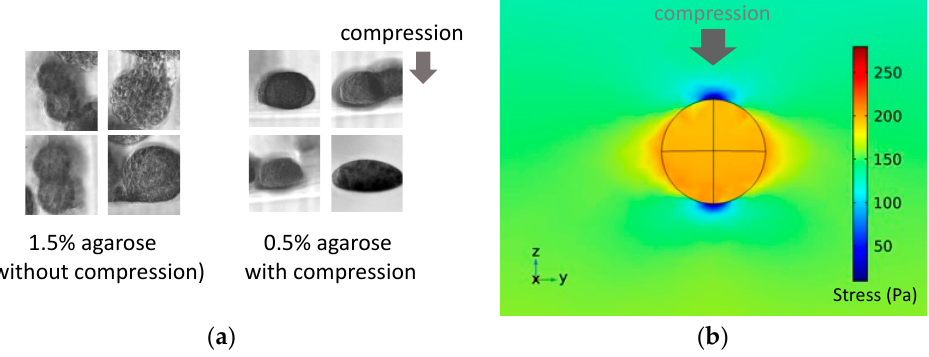
Figure 11. ( a ) Photomicrograph of tumor spheroids in the 0.5% agarose gel observed from the vertical side of the cuvette and ( b ) distribution of the von Mises stress from the numerical analysis simulating the external compressive loading on a spheroid in the agarose gel.